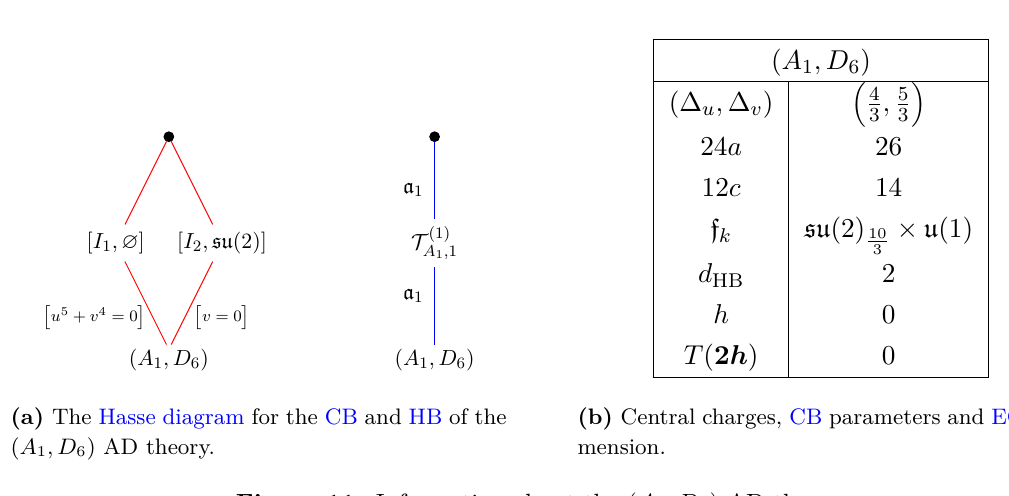
Figure 11. Information about the ( A 1 , D 6 ) AD